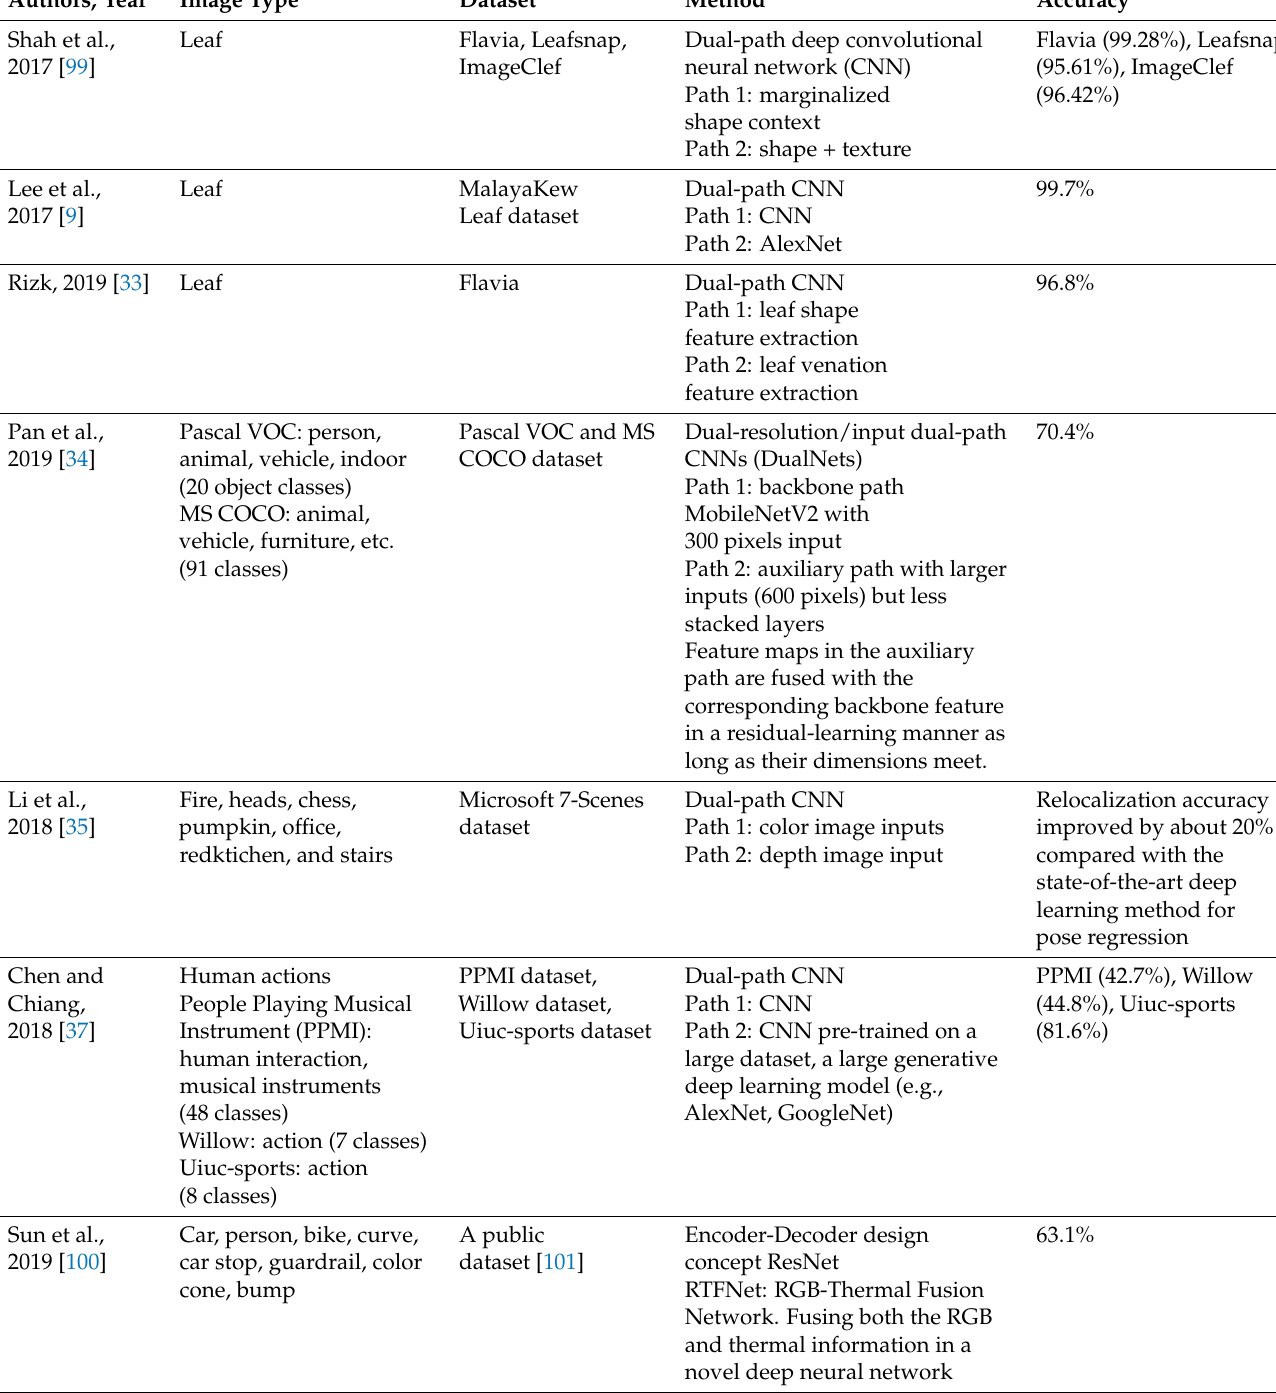
Table 6. Comparison of previous dual-path CNN works and our proposed